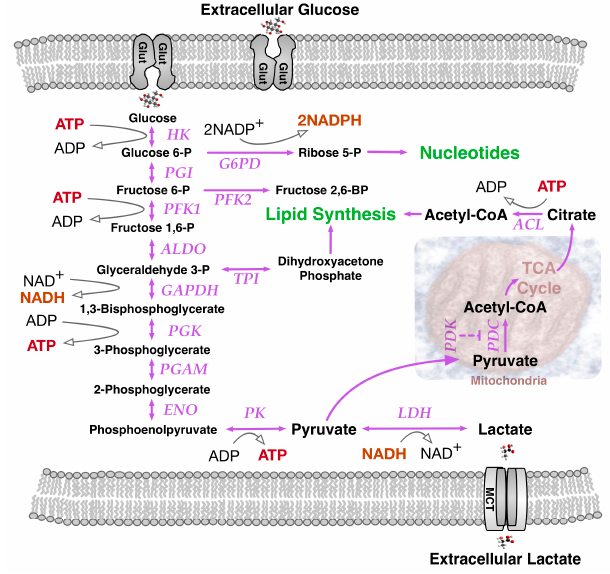
Figure 1. Glucose metabolism in cells. Extracellular glucose enters the cell via GLUT, a glucose transporter protein, that facilitates transport through the lipid bilayer plasma membrane. Subsequently, glucose is metabolized by pathway enzymes including HK, hexokinase; G6PD, glucose-6-phospahate dehydrogenase; PGI, phosphoglucose isomerase; PFK, phosphofructokinase; ALDO, aldolase; TPI, triose phosphate isomerase; GAPDH, glyceraldehyde 3-phosphate dehydrogenase; PGK, phosphoglycerate kinase; PGAM, phosphoglycerate mutase; ENO, enolase; PK, pyruvate kinase. Mitochondrial metabolism regulatory enzyme PDK, Pyruvate dehydrogenase kinase, phosphorylates and inactivates pyruvate dehydrogenase, the first component of PDC, the pyruvate dehydrogenase complex converting Pyruvate to Acetyl-CoA. Oxidation of Acetyl-CoA by TCA, Tricarboxylic acid cycle chemical reactions in the matrix of the mitochondria releases stored energy. The TCA metabolite citrate can be exported outside mitochondria to be broken down into oxaloacetate and acetyl-CoA by the enzyme ACL, ATP citrate lyase. Cytosolic acetyl-CoA serves as a central intermediate in lipid metabolism. When oxygen is in short supply, LDH, lactate dehydrogenase converts pyruvate, the final product of glycolysis, to lactate. MCT, monocarboxylate transporter proteins allow lactate to traverse cell membranes. Solid purple arrows, metabolite transition pathways; thin solid black arrow, coenzyme transition; Dotted T-bar, inhibition.